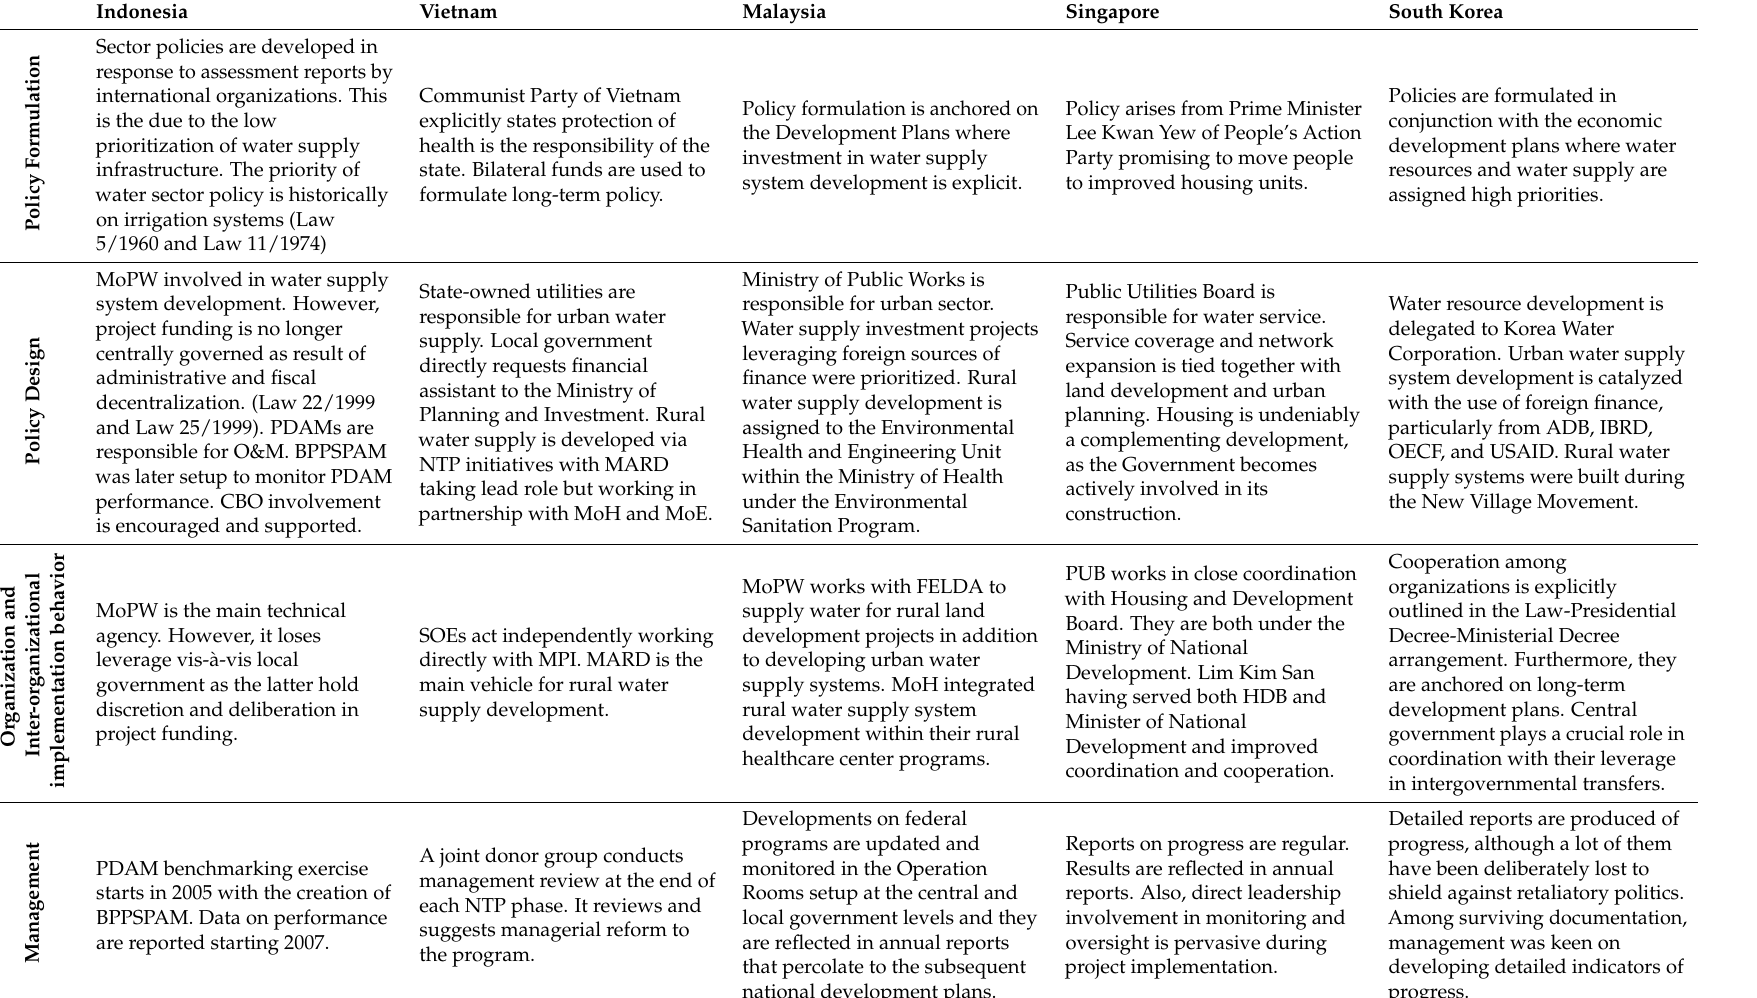
Table 1. Fitting the Case Studies in the Integrated Implementation